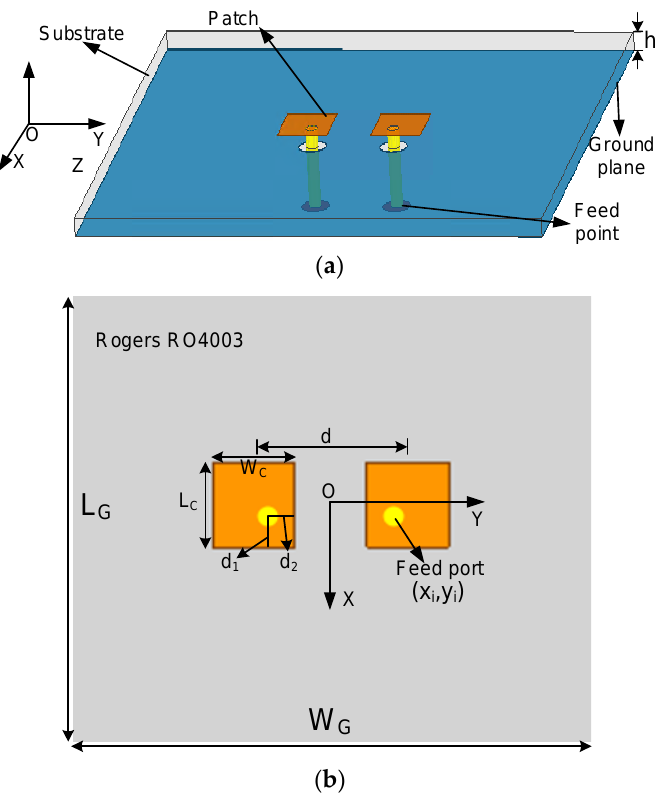
Figure 1. Structure of the proposed antenna array. ( a ) Perspective view. ( b ) Top view.